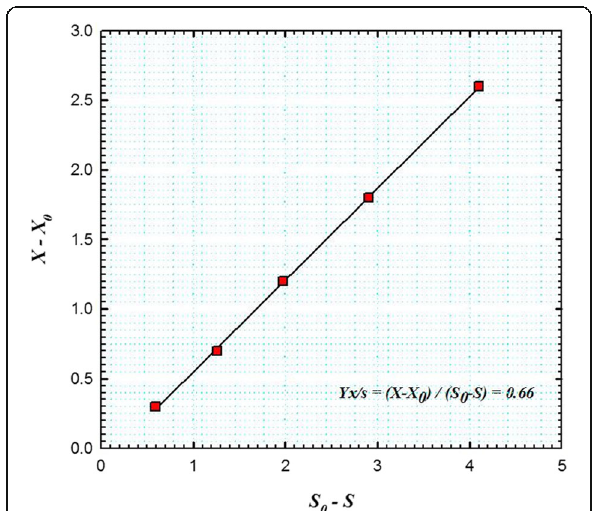
Fig. 9 Ln biomass (X) in g/l as a function of time in the exponential growth phase of batch fermentation no. 2 of Bacillus subtilis isolate B10